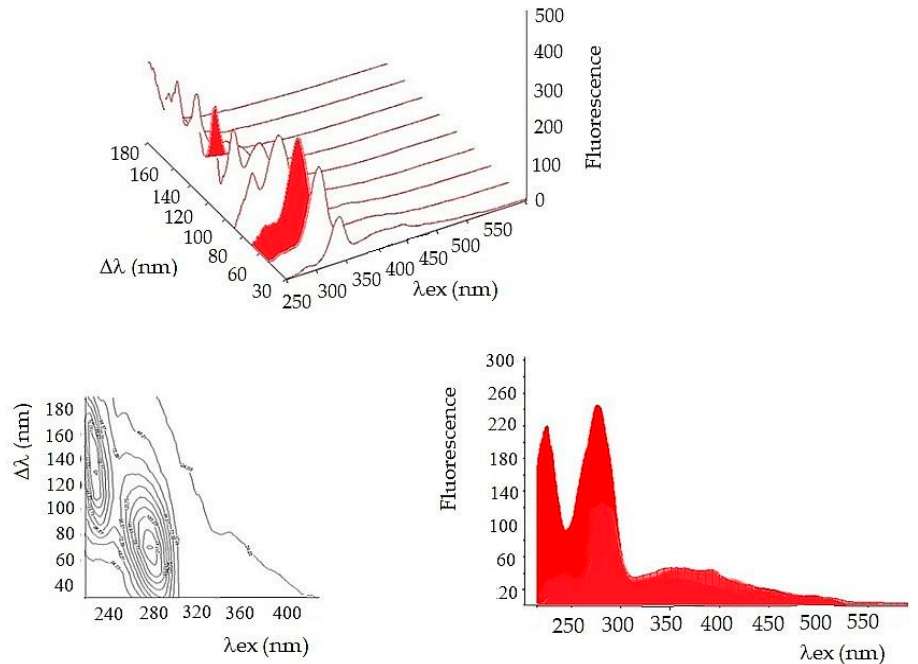
Figure 1. This is a figure of total tear fluorescence presented in different ways. Upper : Arrangement of spectra in a series in a 3D coordinate system. Axis x = excitation wavelength, y = Δλ , z = fluorescence. Bottom right : Synchronous profile (SP). Bottom left : Contour map—synchronous fluorescent map (CWM).